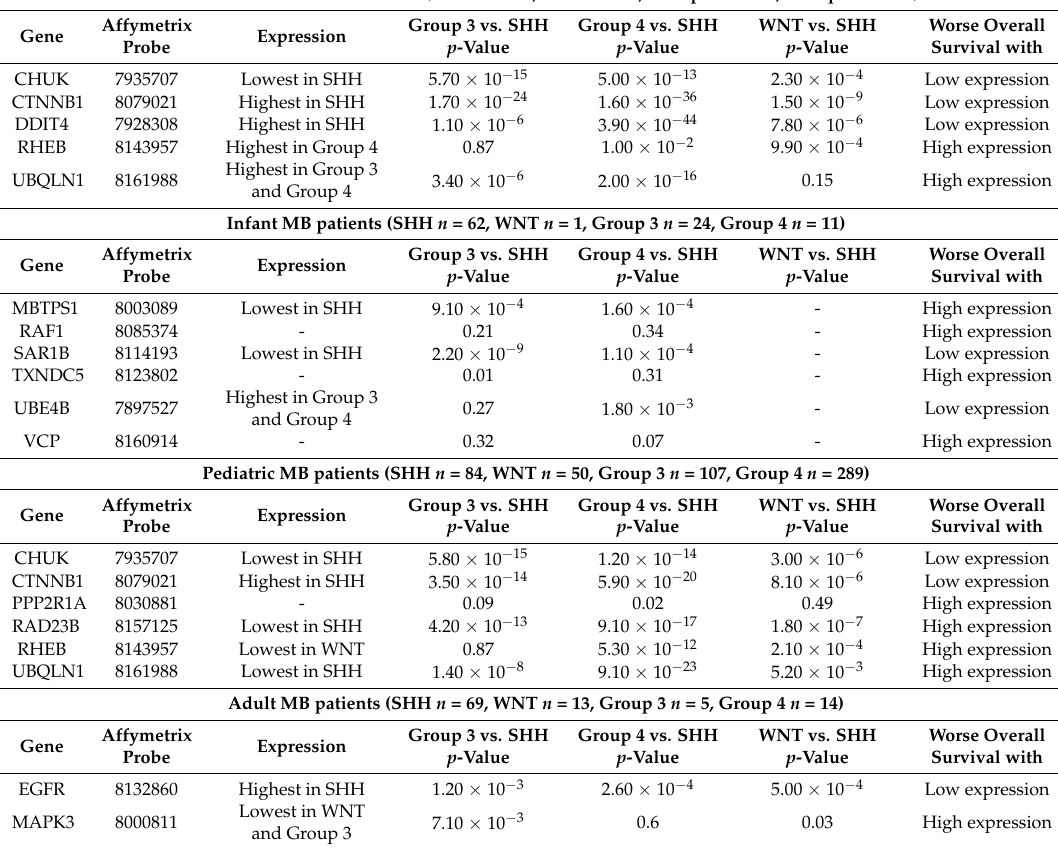
Table 8. Comparison of expression levels of genes of interest (Table 6) in WNT, SHH, Group 3, and Group 4 subtypes (GEO ID: